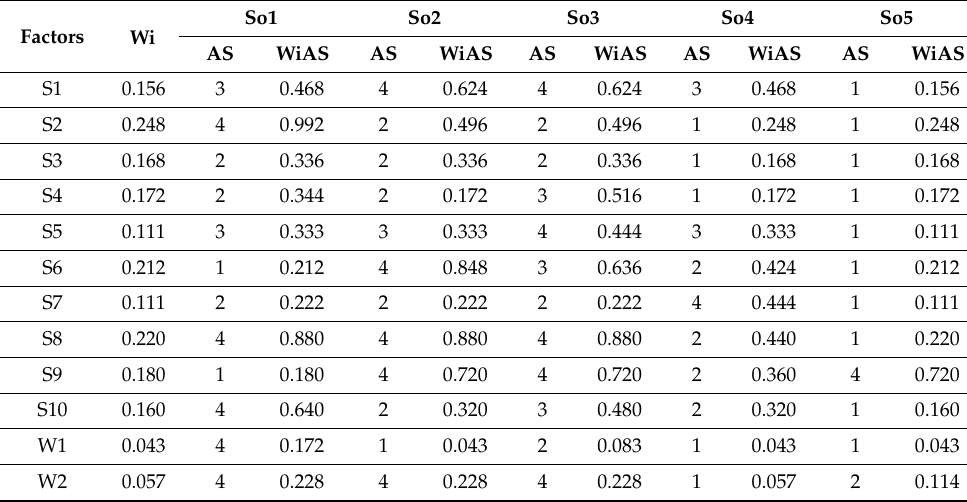
Table 5. Strategic planning matrix for prioritizing water resources management strategies (strengths and